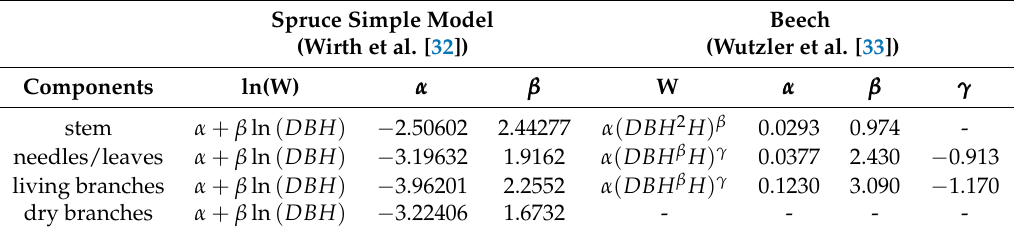
Table 3. Parameters of the allometric models used for tree biomass (and its components) for estimating spruce and beech biomass and its components. W is dry mass of the biomass component, DBH is diameter at breast height, and H is tree height. Spruce Simple Model Beech (Wirth et al. [32]) (Wutzler et al. [33])